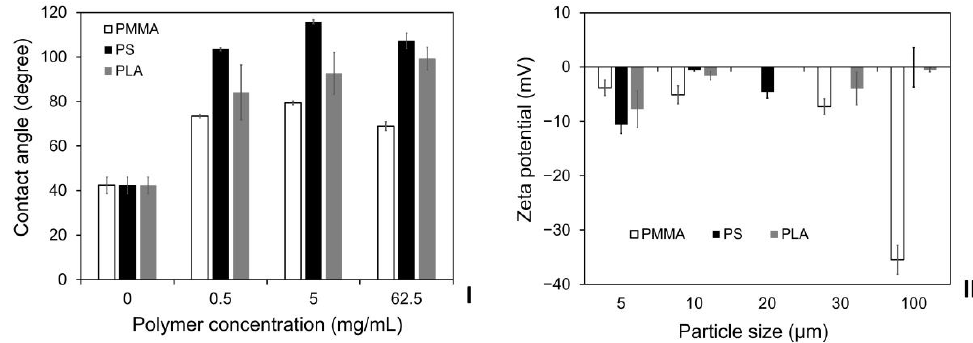
Figure 4. ( I ) The influences of polymeric materials and concentrations on particle wettability. ( II ) The influences of polymeric materials and particle diameter on zeta potential measurement in deionized water. White: PMMA; Black: PS; Grey: PLA. Results shown are mean ± SD ( n = 3 independent